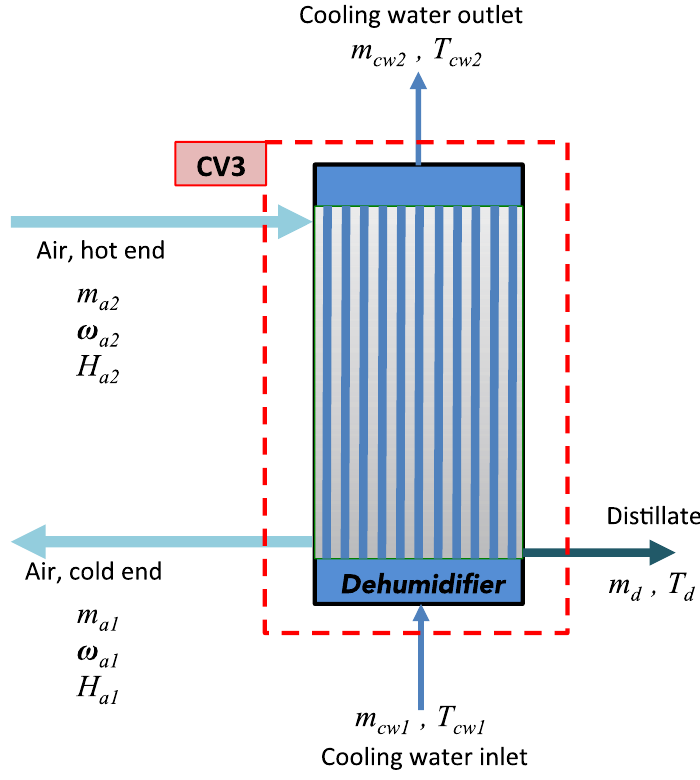
Figure 9. Schematic of the dehumidifier balance.